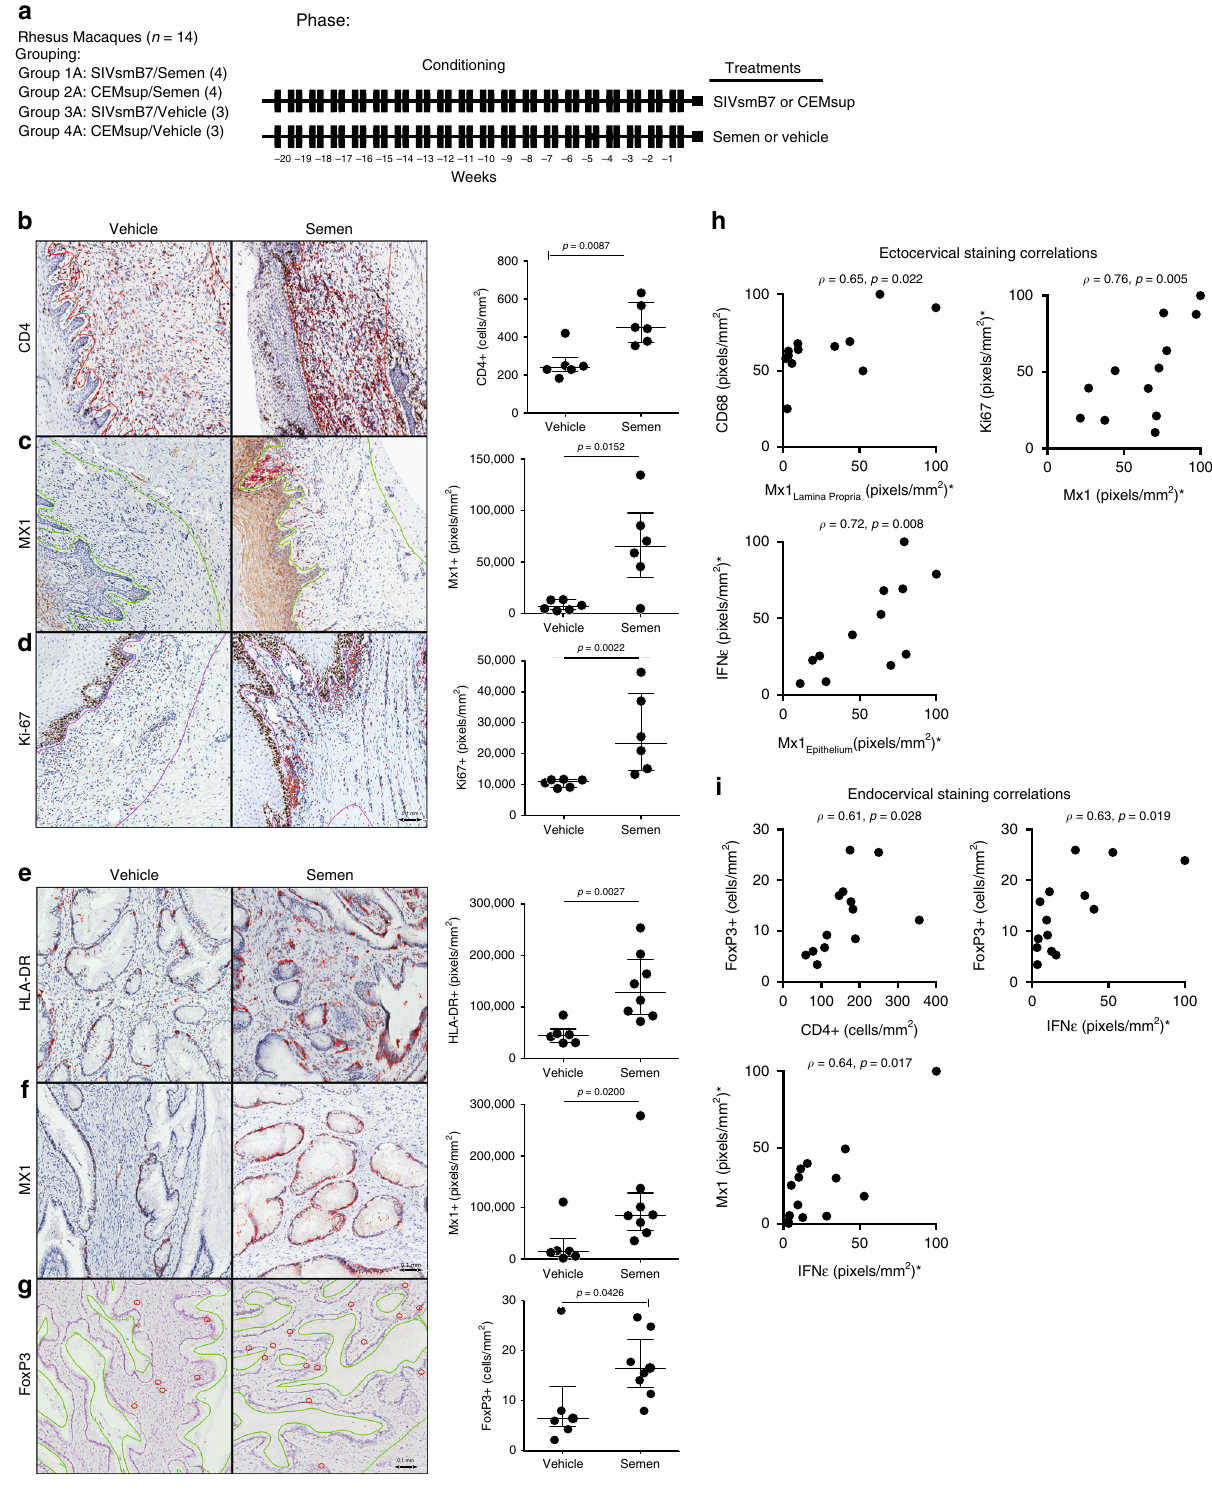
that semen-conditioned animals had higher levels of CCL5 (RANTES) when compared to non-semen-conditioned animals (Fig. 2d; p =